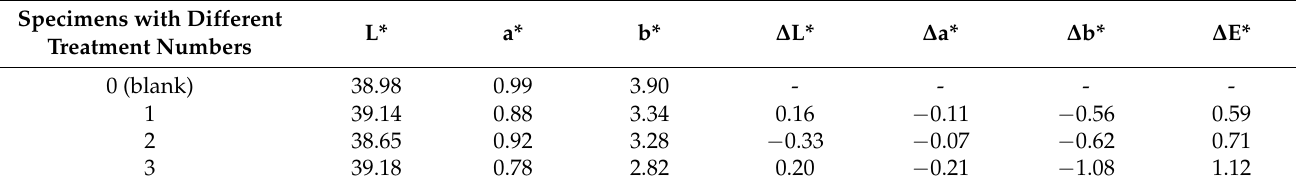
Table 2. Color differences of the specimens before and after treatment.